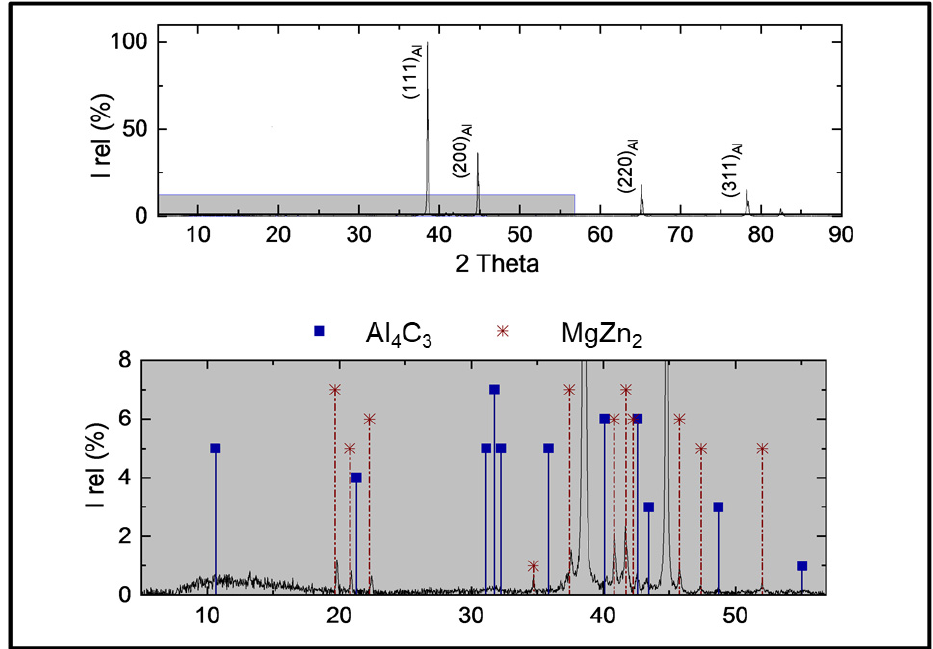
Figure 14. XRD pattern of extruded 7075-1 wt.% MWCNT.